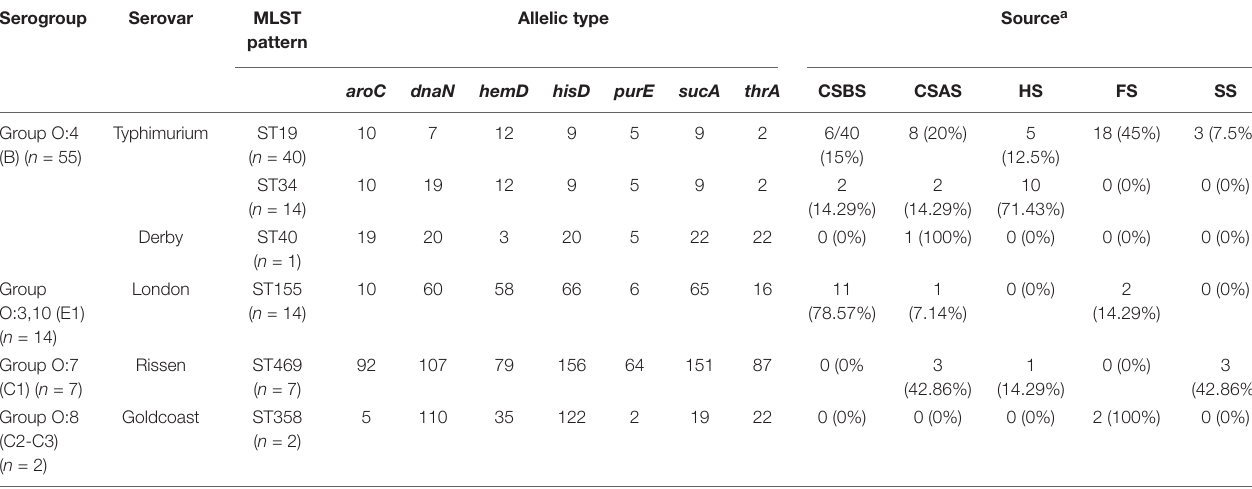
TABLE 3 | Allelic profiles, serogroups, serovars, and MLST patterns of Salmonella isolated from different sources. Serogroup Serovar MLST Allelic type Source a pattern aroC dnaN hemD hisD purE sucA